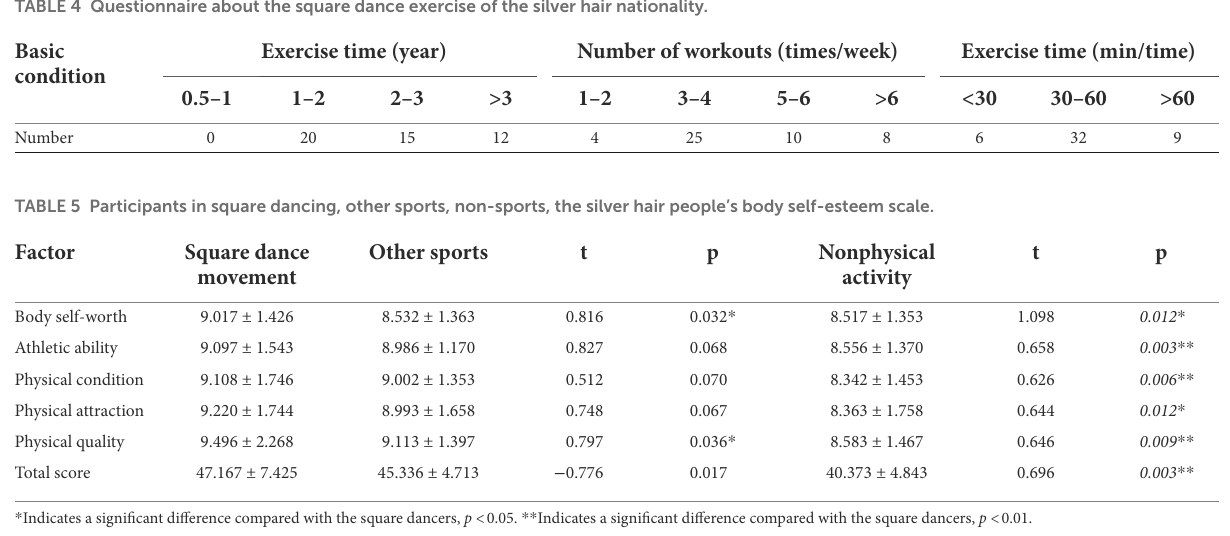
TABLE 6 Participants in square dancing, other sports, and non-sports on the well-being scale of silver hair. Factor